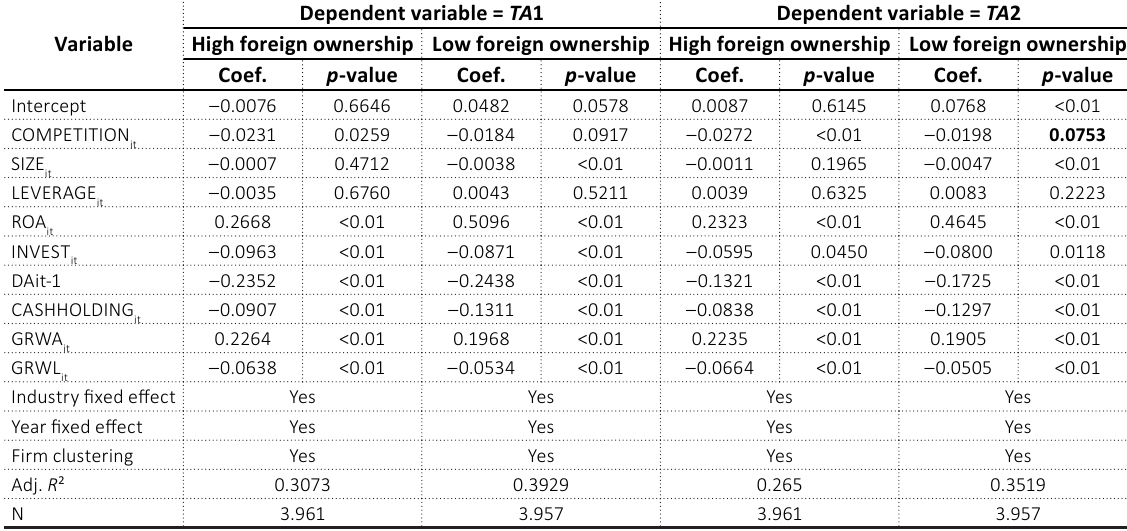
Table 7. The effect of foreign investors on the relationship between product market competition and tax avoidance